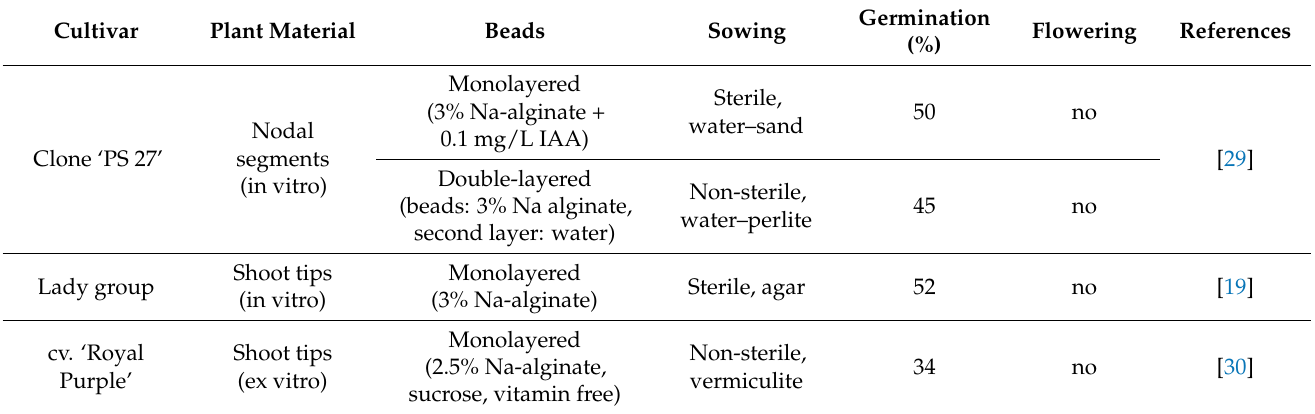
Table 1. Application of synseed technology for storage and propagation of chrysanthemum